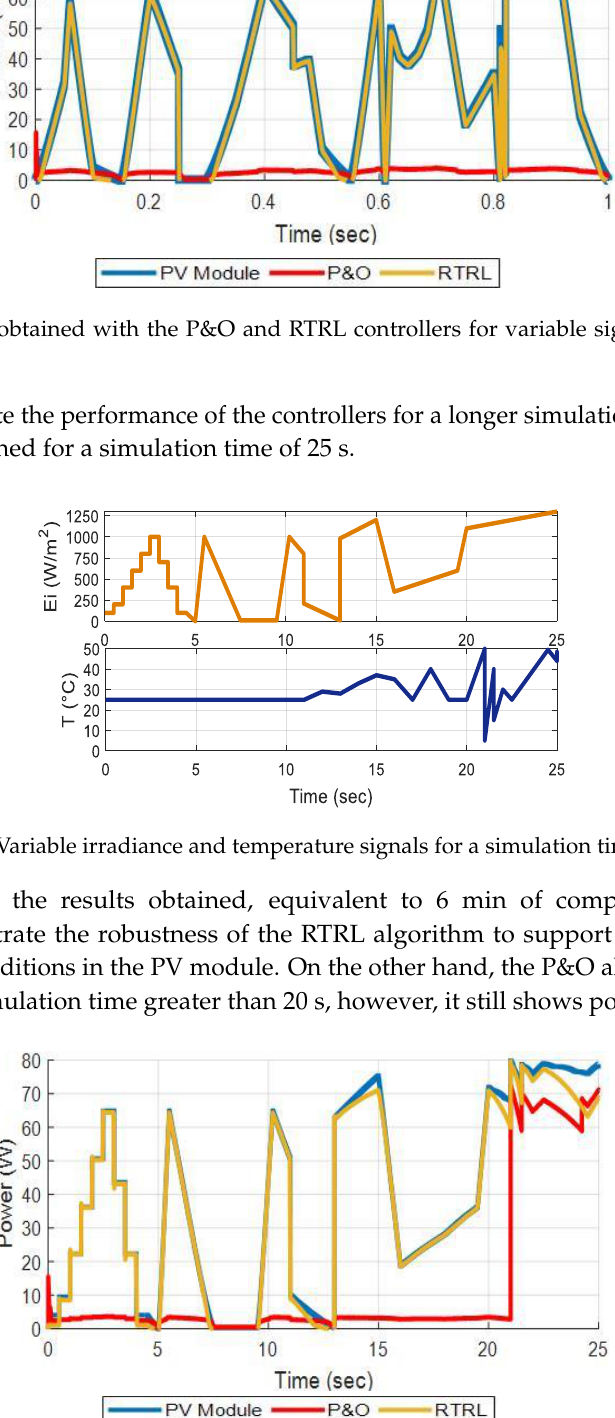
Figure 19. Results obtained with the P&O and RTRL controllers for variable signals of irradiance and temperature with a simulation time of 25 s.